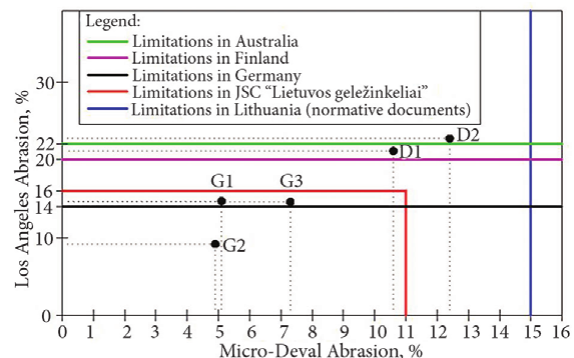
Fig. 3. Determination results of particles resistance to wear and fragmentation and maximum permissible values of these parameters in Lithuania and abroad